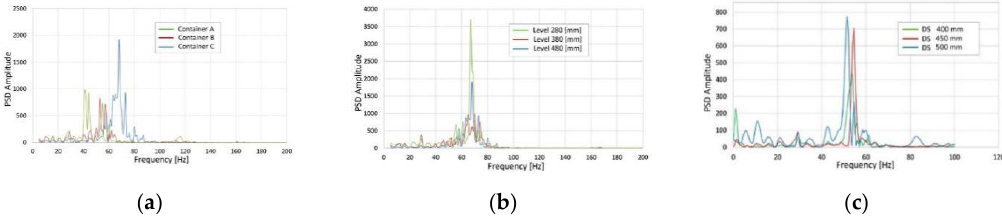
Figure 9. ( a ) Influence of the container mass on the PSD of the load cell signal. ( b ) Influence of the tank filling level on the PSD of the load cell signal; ( c ) Influence of the distance DS (between the dispenser and the plate).